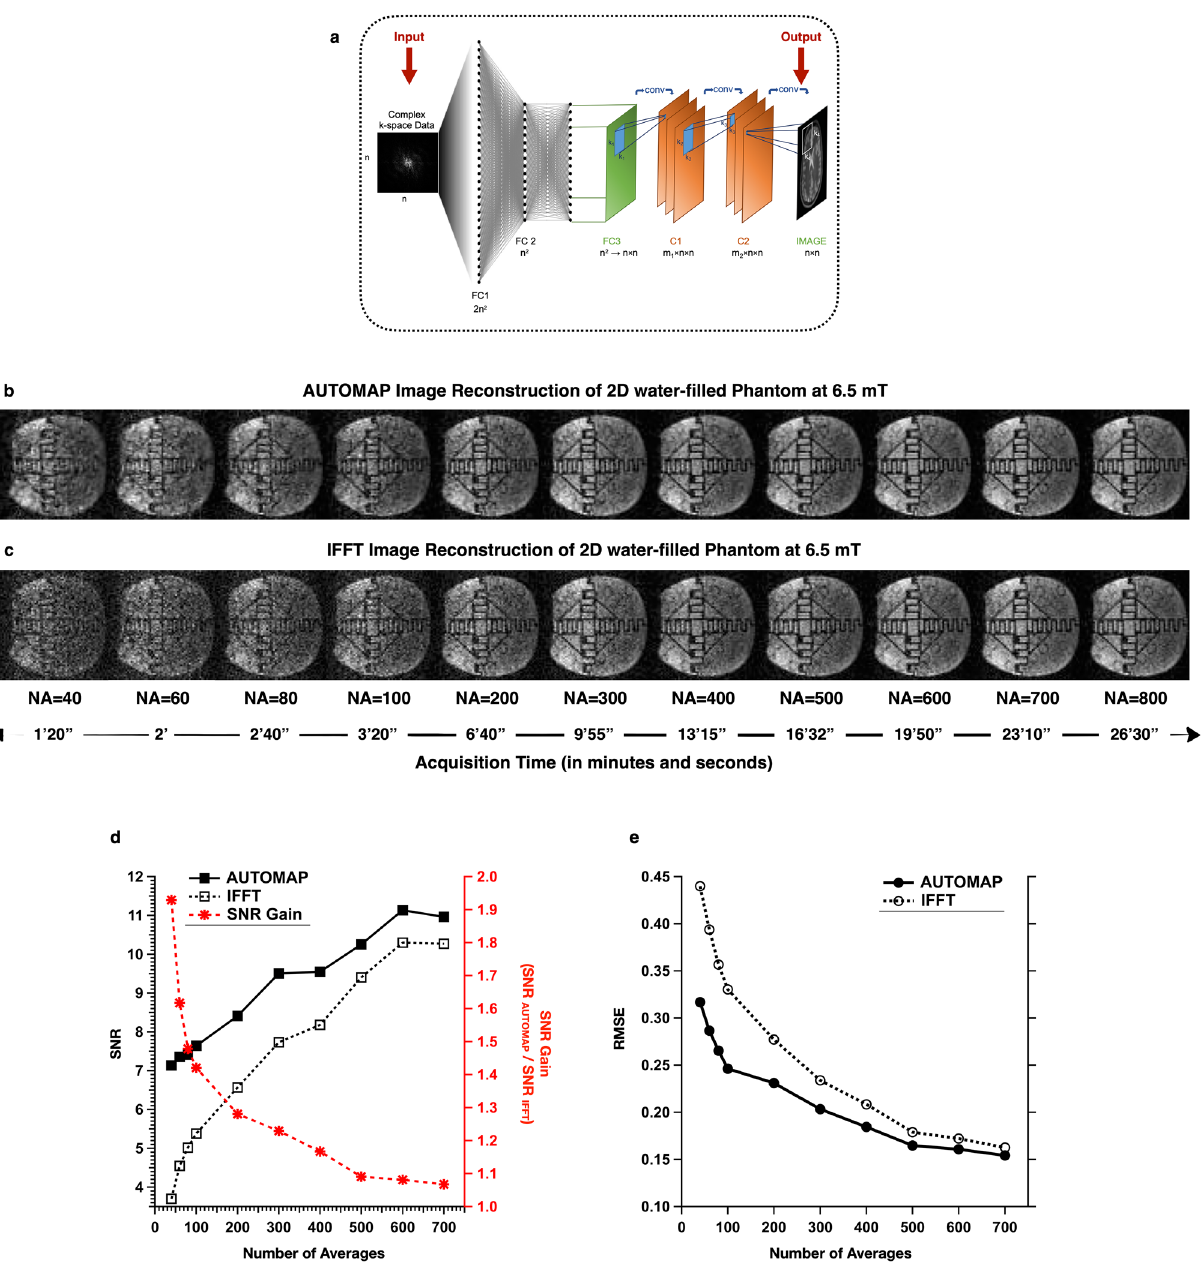
Figure 1. AUTOMAP neural network architecture and AUTOMAP image reconstruction at 6.5 mT—( a ) the neural network architecture adapted from 10 —the input to the network is the complex k -space data and the real and imaginary outputs are combined to form the final image. The network is comprised of two fully connected layers followed by two convolutional layers. ( b , c ) Comparison of AUTOMAP reconstruction with IFFT reconstruction for 2D imaging in a water-filled structured phantom—Images were acquired with a bSSFP sequence (matrix size = 64 × 64, TR = 31 ms at 6.5 mT. The number of signal averages (NA) increases from left to right with their respective scan time shown below. ( b ) Upper panel shows AUTOMAP-reconstructed images and ( c ) the lower panel shows same image reconstructed with IFFT. The window level of reconstructed images ( b , c for each NA) is identical. ( d ) SNR Analysis of the 2D phantom dataset as a function of the different number of averages. The mean SNR versus NA is plotted on the left axis for AUTOMAP (filled square) and IFFT (open square). The SNR gain over IFFT is plotted (in red) on the right axis. ( e ) The Root Mean Square Error (RMSE) of the AUTOMAP reconstructed images (filled circle) and the IFFT reconstructed images (open circle) were evaluated with respect to the 800-average IFFT reconstructed image as